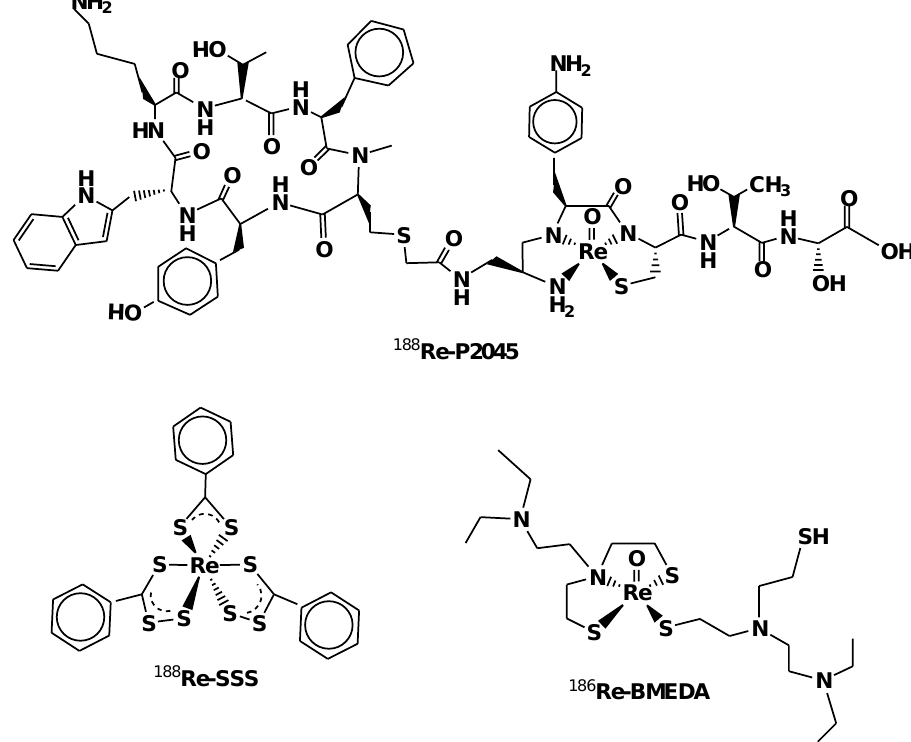
Figure 5. Chemical structure of 188 Re-P2045, 188 Re-SSS, and 186 Re-BMEDA radiopharmaceuticals.